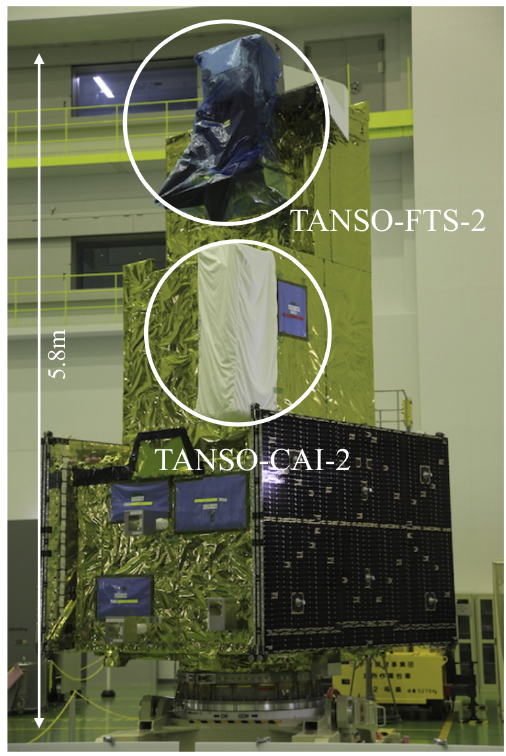
Figure 1. Photograph of GOSAT-2 before